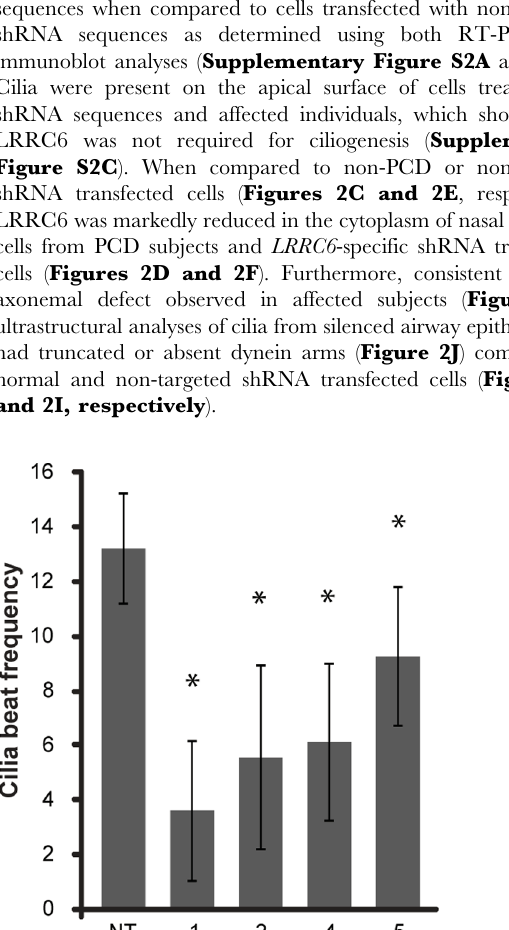
Figure 3. Inner and outer dynein protein mislocalization. Immunofluorescent staining of airway epithelial cells cultured at an air-liquid interface from normal (NL) and PCD subjects (PCD) for DNAI1 (red) ( A ), showing that outer dynein arm marker was localized to cilia of normal cells, but not in PCD cells. DNAI1 was present in the cytoplasm and most prominent beneath the ciliary axoneme in the PCD subject, suggesting mislocalization. The inner dynein arm marker, DNAH7 (red) ( B ), was localized to cilia of normal airway epithelial cells (NL) but absent in cells collected from PCD subjects (PCD). Immunofluorescent staining for DNAI1 or DNHA7 (red), a -tubulin (green) and DAPI (blue) (Scale bar=10 m m).